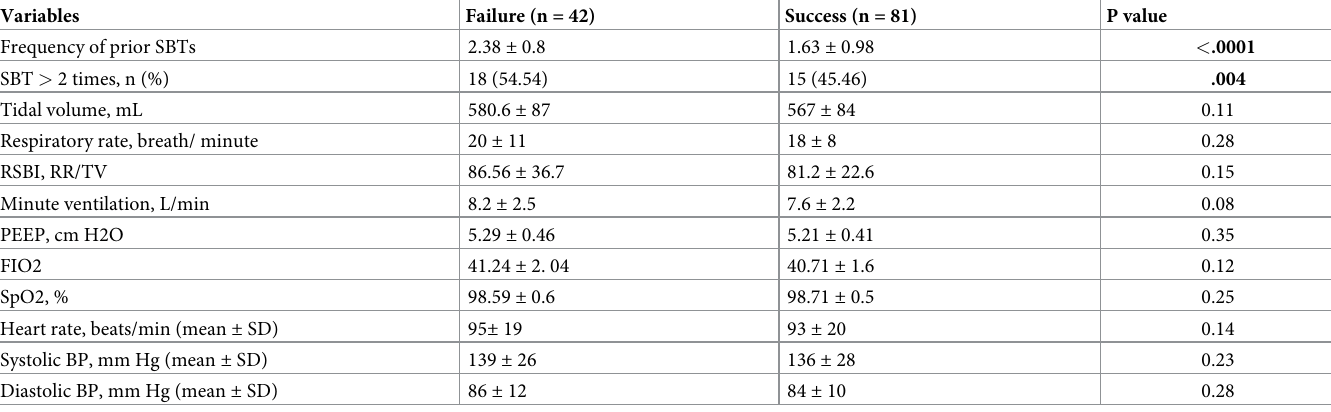
Table 3. Characteristics during spontaneous breathing trials between extubation success and extubation failure